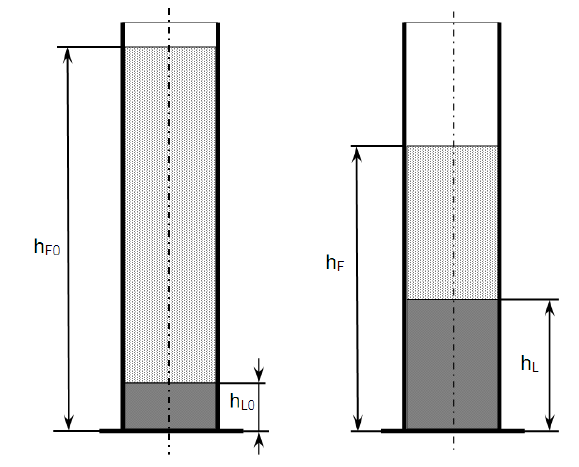
Fig. 3. Measured properties .